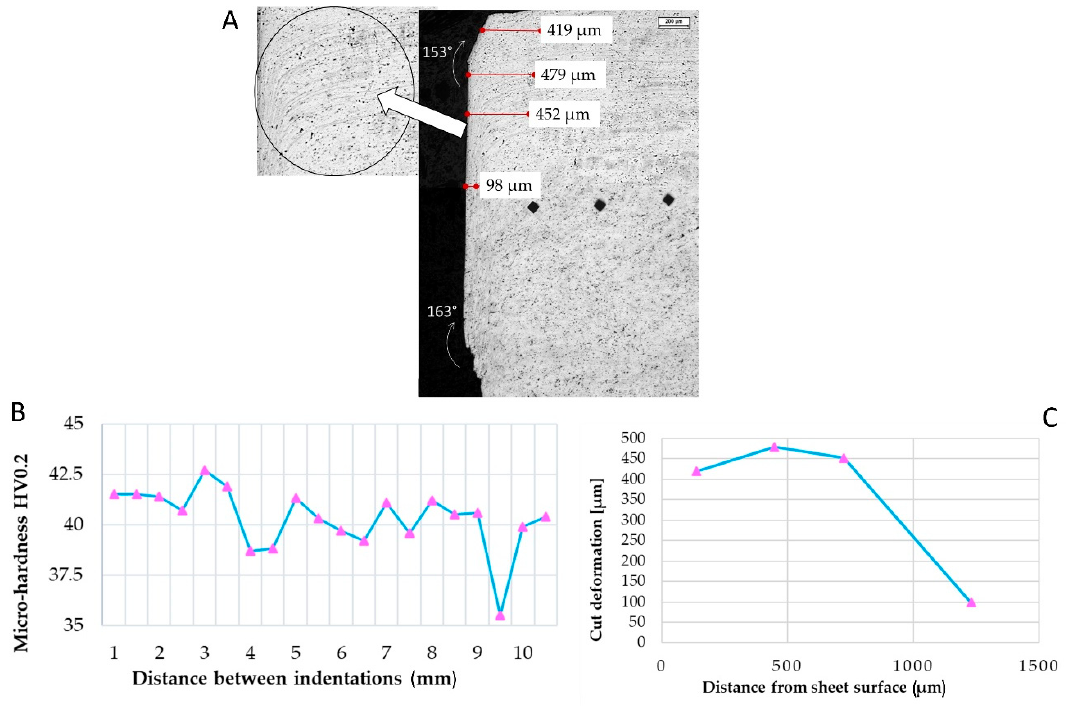
Figure 4. ( A ) Microscope image of the shearing cutting trace on AA1070 sheet. ( B ) Distortions in the first 1200 µm were documented. ( C ) Micro-hardness measured along the first 10 mm starting from the cut edge. Marker: 200 µm.